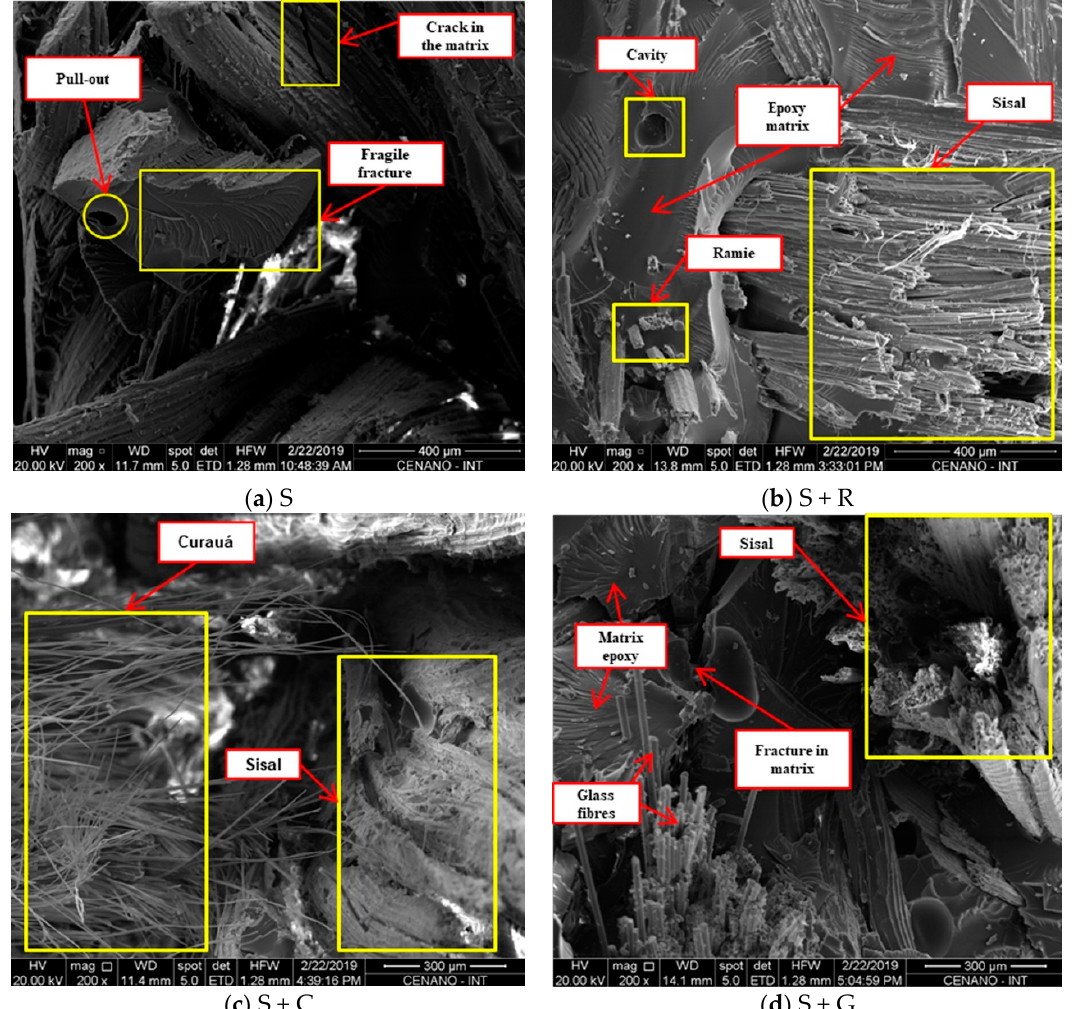
Figure 4. SEM images of fracture surface of tensile specimens as a function of hybridization. ( a ) S; ( b ) S+R; ( c ) S+C and ( d ) S+G.